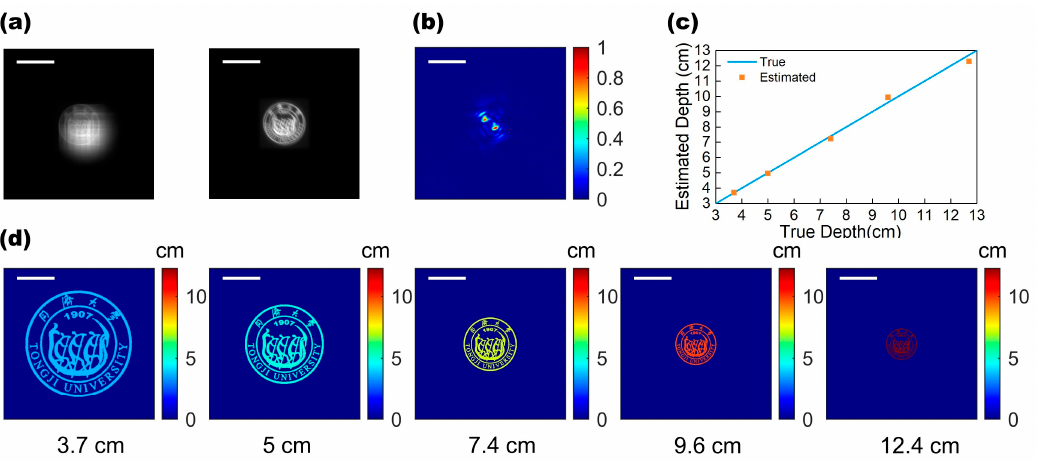
Figure 4. Single-object depth imaging. ( a ) Convolution blurred images (depth 7.4 cm) on simulated receiving screen, including cubic image of EDOF metalens ( left ) and helical image of DH-PSF metalens ( right ). Scale bar: 0.5 mm. ( b ) The DH-PSF was estimated using the image in ( a ). Scale bar: 0.1 mm. ( c ) The estimated object depths (orange points) are compared with the actual depth (blue line). ( d ) Clear reconstructed depth images of five different distances with the same color bar. Scale bar: 0.385